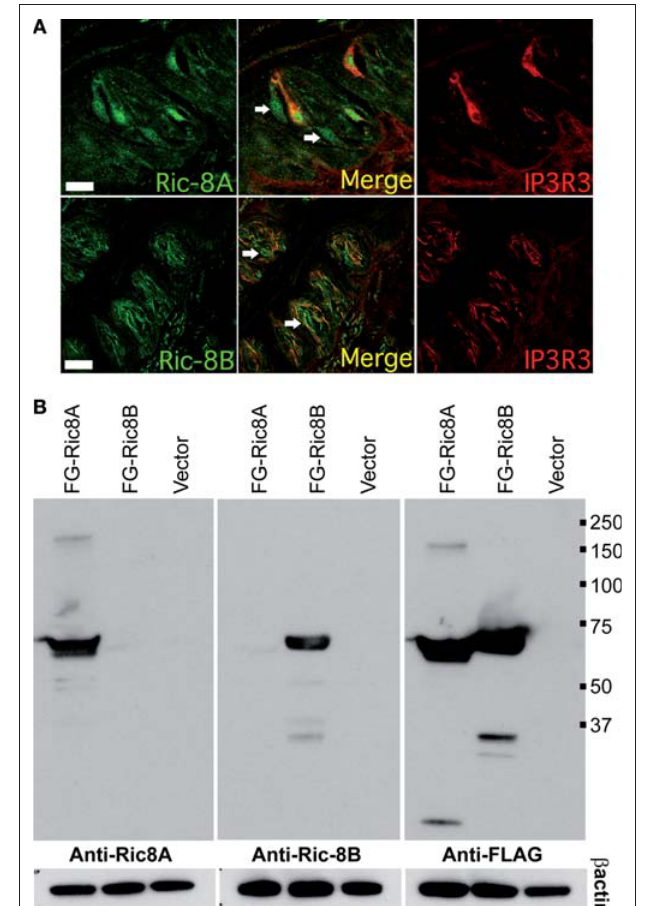
FIGURE 3 | Ric-8 expression is not strictly confi ned to type II taste bud cells. (A) Double labeling immunohistochemistry on sagittal sections of circumvallate papillae using an antibody raised against IP3R-3 visualized with an Alexa555 coupled secondary antibody (red) and either an anti-Ric-8A (top row) or anti-Ric-8B (bottom row) antibody visualized with an Alexa488 secondary antibody (green). Middle panels are merged images showing co-localization. All IP3R-3 cells display Ric-8A and Ric-8B labeling but not all Ric-8A or Ric-8B cells are positive for IP3R-3 (white arrows) indicating that Ric-8A and Ric-8B expression extends to other cells beside IP3R-3 positive cells. (Scale bar top row = 20 µm; bottom row = 40 µm). (B) Western blotting analysis of whole cell lysates from cells transiently transfected with either Flag-Ric-8A (FG-Ric8A), Flag-Ric-8B (FG-Ric8B) or the expression vector alone (Vector) using anti-Ric-8A (left panel), anti-Ric-8B (middle panel) or anti-Flag (right panel) antibodies. A single band around 64 kDa for recombinant Flag-Ric-8A and ∼ 71 kDa for Flag-Ric-8B is detected in HEK 293T cells thus clearly showing that Ric-8 antibodies do not cross-react with the paralogous protein. Bottom panels show β -actin loading controls. [Right margin: molecular weight marker bands